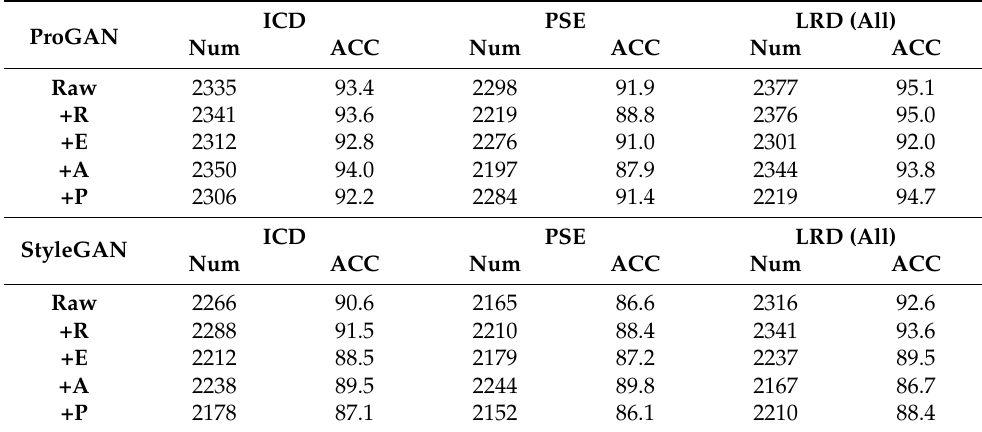
Table 4. The ablation study in the local region detection branch using ProGAN and StyleGAN. (Test criteria adopt accuracy (%)).